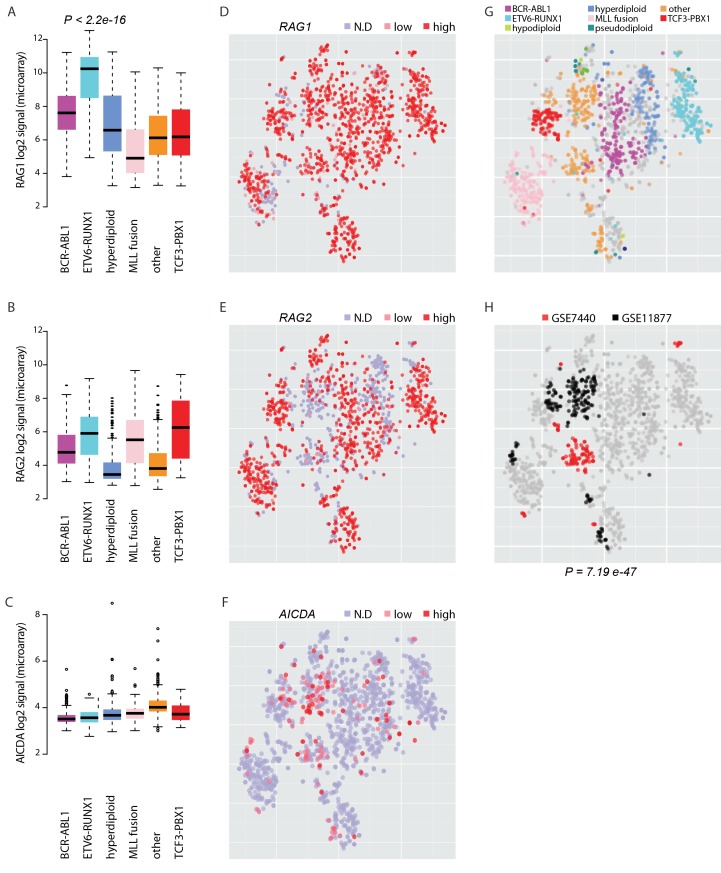
Expression of AID and RAG across molecular subtypes of leukemia.The log2 expression signal is summarized as boxplots for (A) RAG1 (B) RAG2 and (C) AICDA across the pre-B-ALL subtypes (N = 153 BCR-ABL1, N = 153 ETV6-RUNX1, N = 151 hyperdiploid, N = 198 MLL rearrangement, N = 267 other, N = 82 TCF3-PBX1). Wilcoxon rank sum test p-value is indicated for differential RAG1 expression in the ETV6-RUNX1 subtype (N = 153, patients with cytogenetic subtype information N = 1008) (in A). (D–F) Alternative representation of discrete expression states for RAG1, RAG2, and AICDA, respectively (red: high, pink: low, grey: not detected). The data points shown as a t-SNE map correspond to the full set of pre-B-ALL patient samples (N = 1382) (see also Figure 5—source data 1). Their relative positions are defined by the transcriptome similarity. The sample groups can be compared to annotated cytogenetic types, as colored on the same map in (G, H). The location of high-risk samples (N=295) from two independent studies is indicated in color on the same map (COG studies GSE7740 in red and GSE11877 in black, see also Supplementary file 5). Hypergeometric test p-value is indicated for enrichment of detected AICDA expression in the high risk studies (N = 112, refer to Supplementary file 5 for population statistics).DOI:
http://dx.doi.org/10.7554/eLife.13087.02810.7554/eLife.13087.029Figure 5—source data 1.pre-B-ALL transcriptome samples.Sample identifiers of pre-B-ALL transcriptomes analyzed and their coordinates on the dimensionality reduction plot.